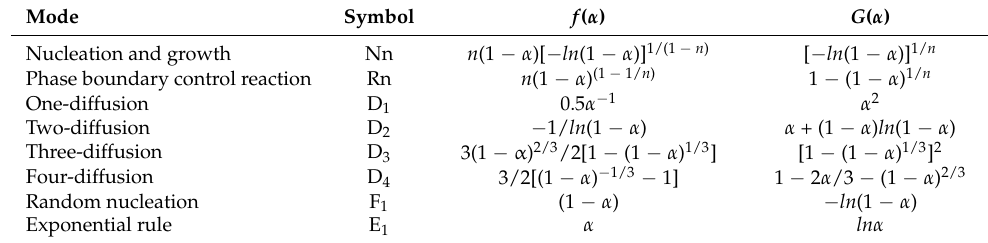
Table 1. The common mode functions of the solid